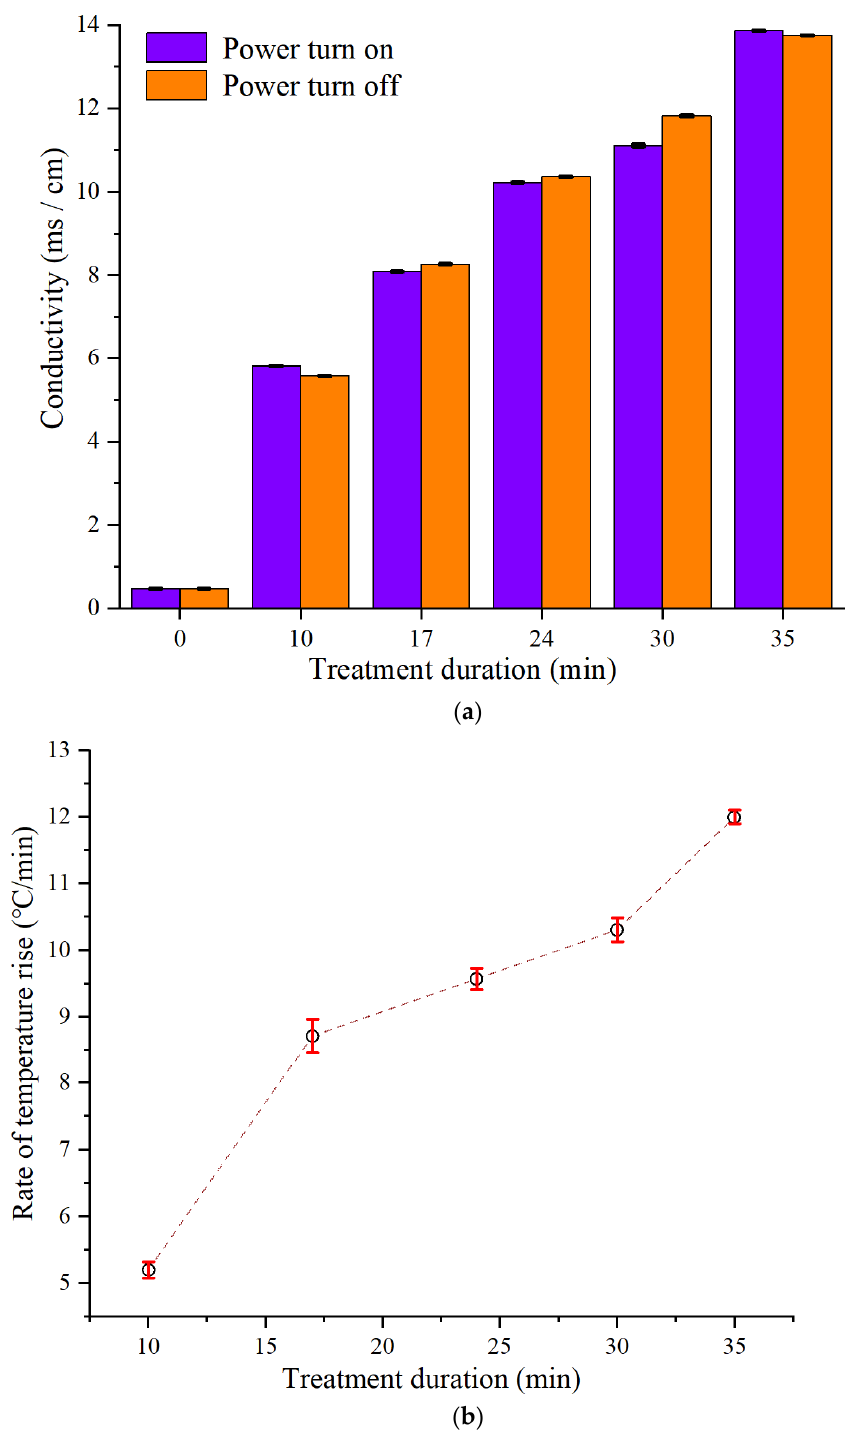
Figure 4. ( a ) Effect of the treatment duration on the sample conductivity; ( b ) Effect of the treatment duration on the temperature rise.